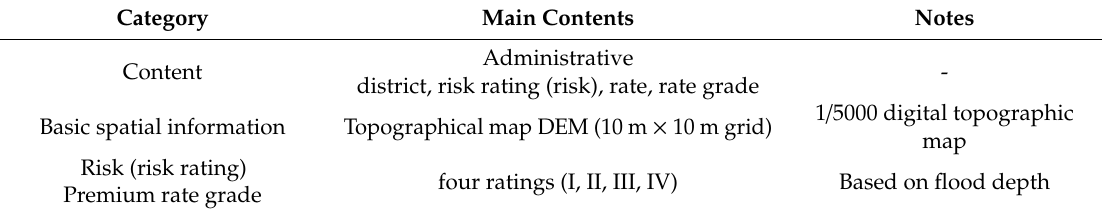
Table 5. Final database structure of Map for Storm and Flood Insurance Management.